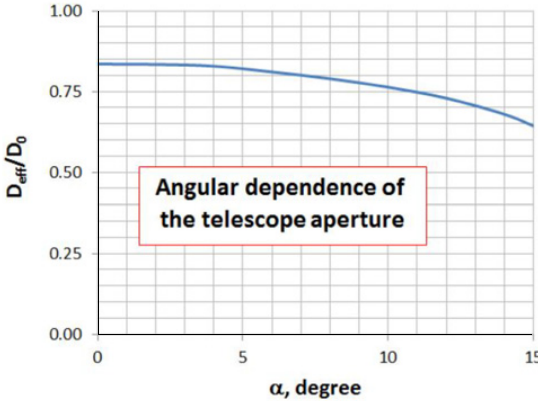
Figure 4. Shadowing of the mirror by the PMT and support + cables. The ratio of effective mirror diameter to the unshielded diameter as a function of incidence angle, α